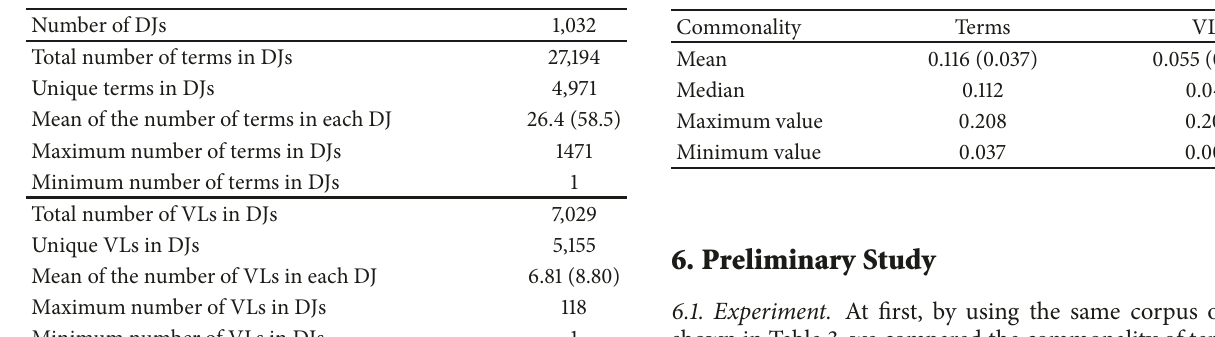
Table3:CorpusstatisticsofVQ(parenthesesrepresentthestandard deviation).